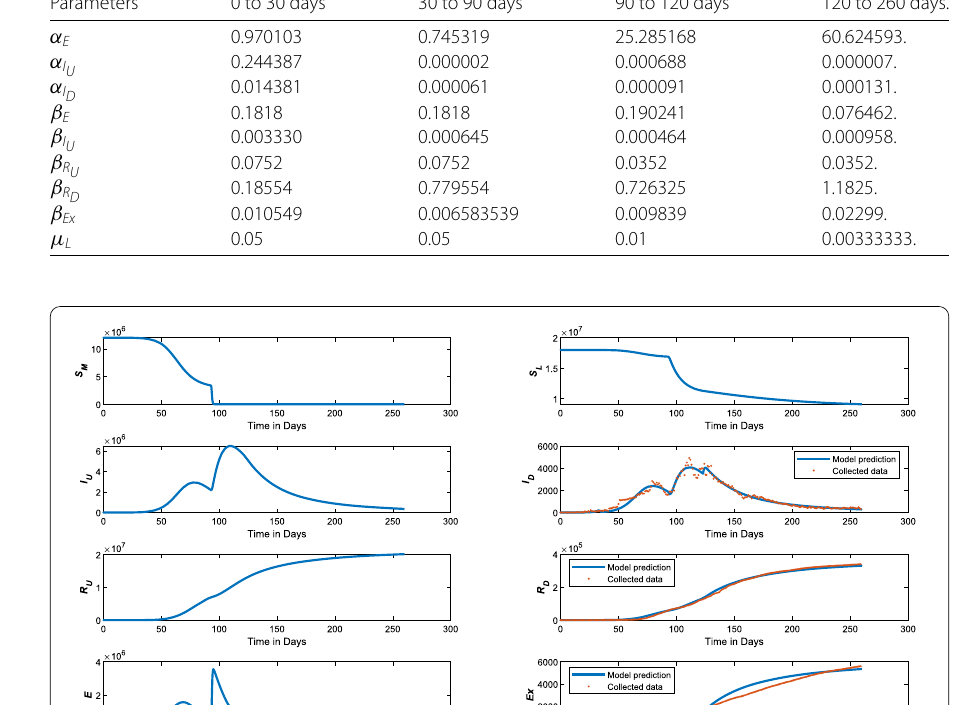
where d j represents the data measurement available at the time t j , N stands for the number of measurements, and x ( t j , θ ) represents the ( COVID-19 ) model equations (1)–(8). The best fit relative estimation of the control parameters α E , α I , β R , β Ex of recovered, and the dead compartments are given in Table parameters β R U D